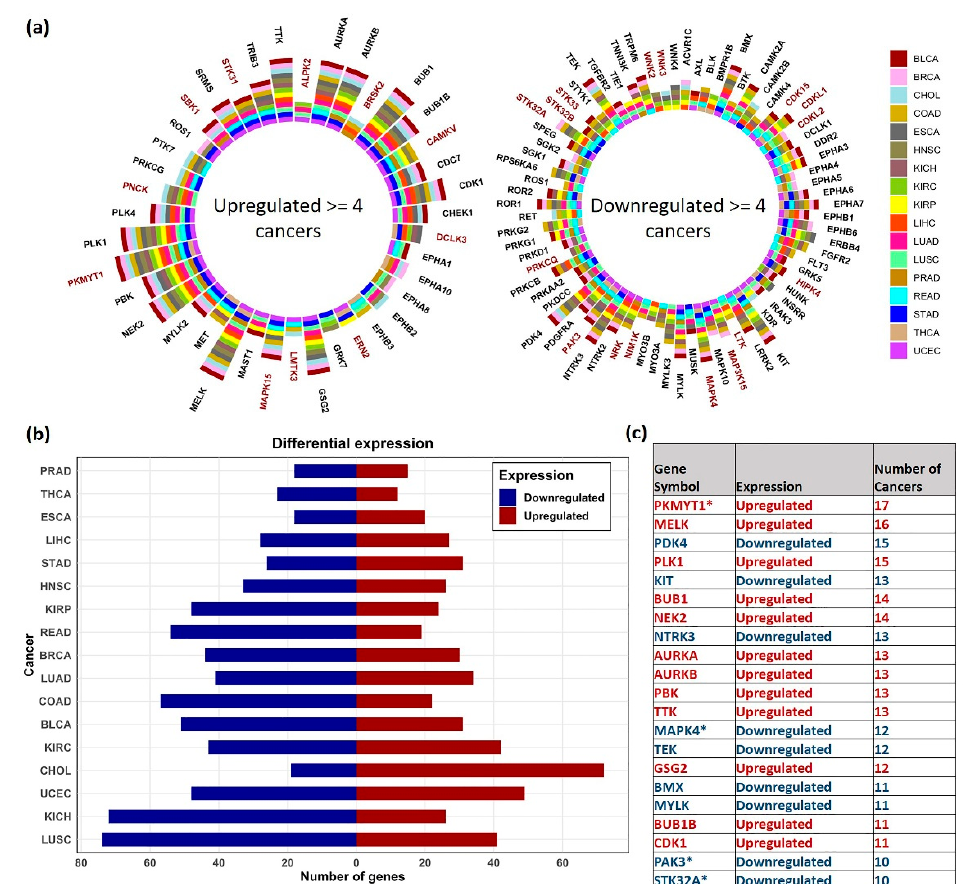
Figure 2. Distribution of the differentially expressed genes. ( a ) Sunburst plot showing the top DE kinase genes in ≥ 4 TCGA cancer types. Dark kinases are highlighted in maroon ( b ) Number of Upregulated (red) and downregulated (blue) kinase genes observed in analyzed cancers. ( c ) Table showing the list of common DE genes obtained in ≥ 10 cancers, the direction (upregulated—red, downregulated—blue) and in number of cancers observed. Dark kinases are marked with * sym- bol.